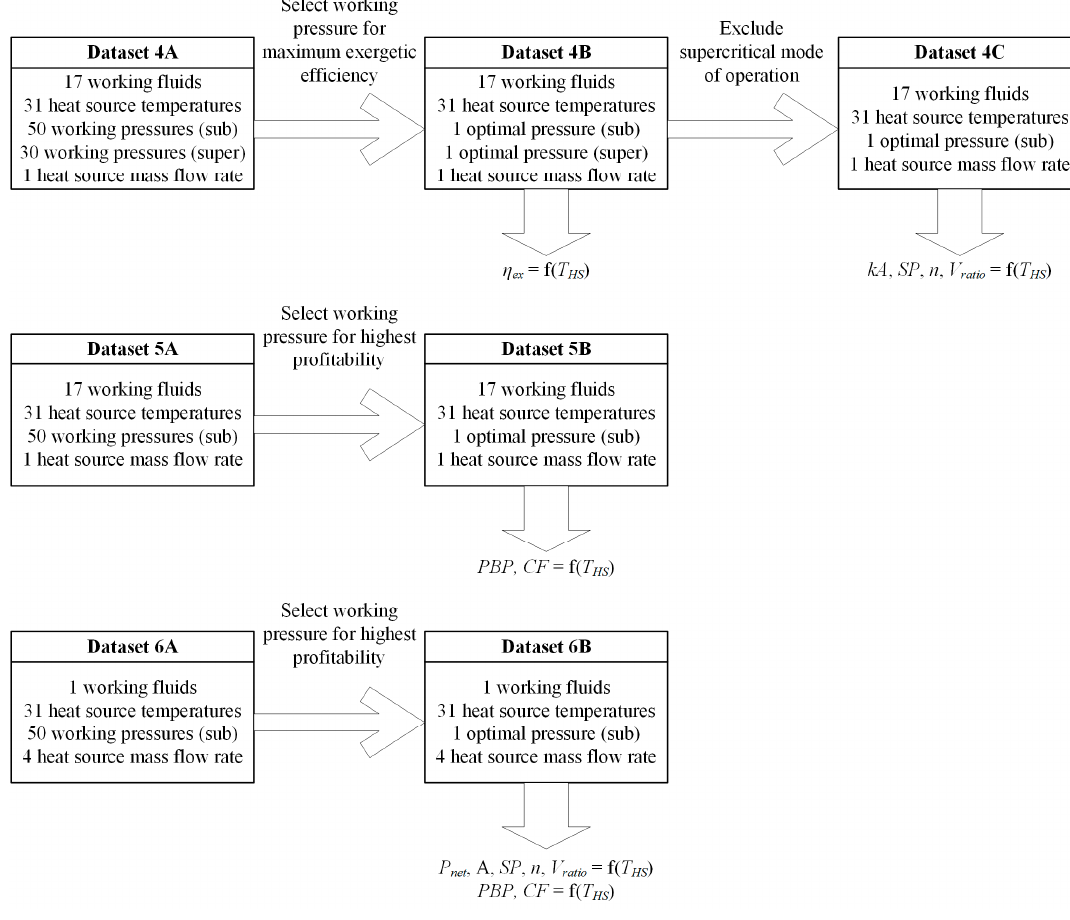
Figure 4. Overview of datasets (defined in Section 3.5) used in each chapter and results of related parameters (defined in Sections 3.4 and 5.2).